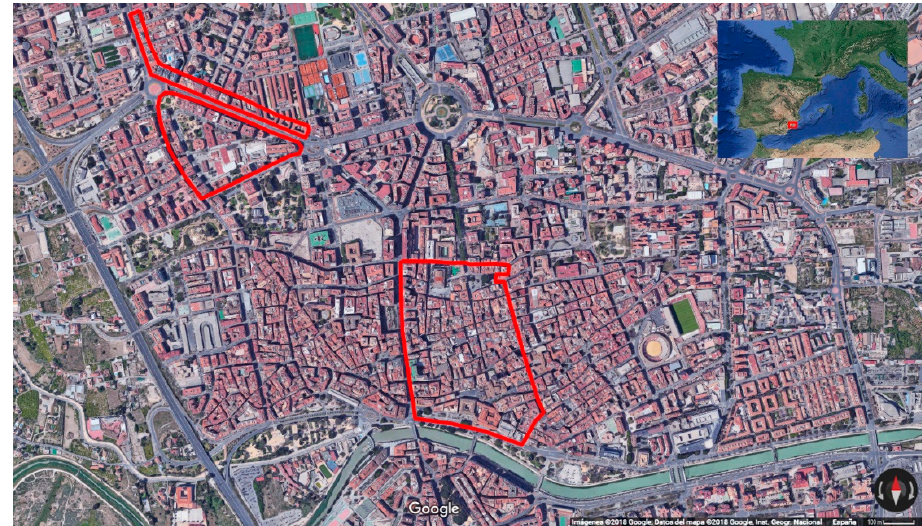
Figure 1. Satellite image of the city of Murcia, Spain. The area studied in the fieldwork is marked in red. Source: Google Earth.